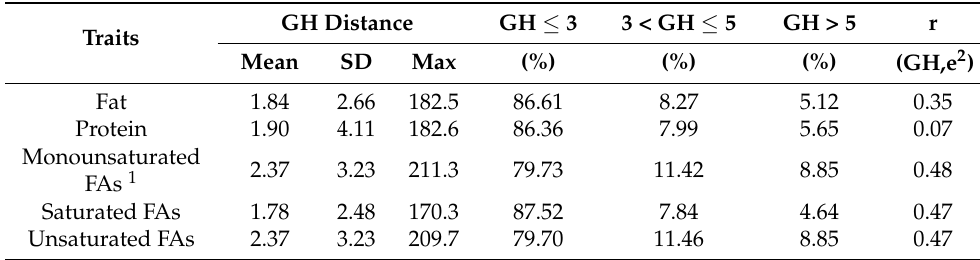
Table 4. Descriptive statistics of Global-H (GH) distances and their correlation coefficient (r) with the squared differences between the manufacturer’s and externally predicted traits (e 2